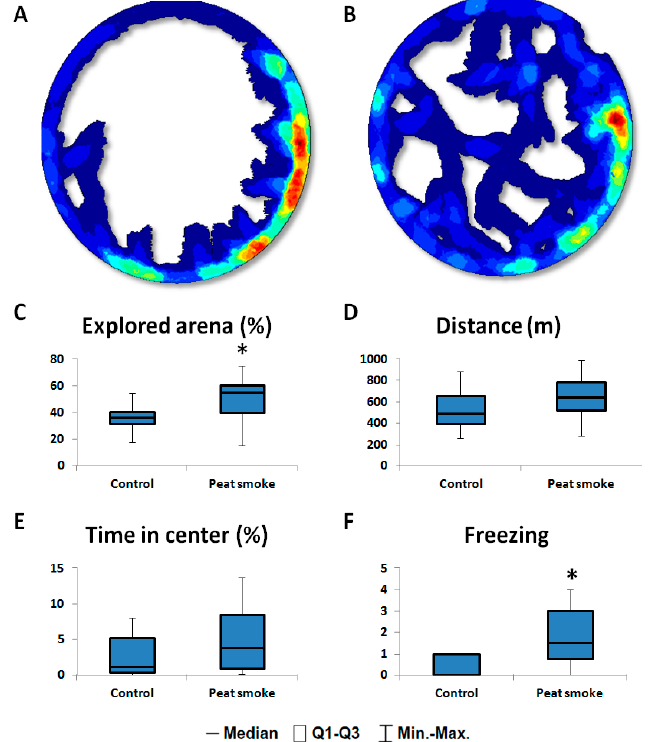
Figure 1. Effects of peat smoke exposure in F0 rats in an OFT. Representative images of animal activity during testing (red—highest activity; blue—lowest activity): ( A ) Control group; ( B ) rats exposed to peat smoke; ( C ) Area of the explored arena (%); ( D ) Total distance; ( E ) Time elapsed at the center; ( F ) Number of freezing episodes. Data are presented as median and IQR. * p < 0.05.